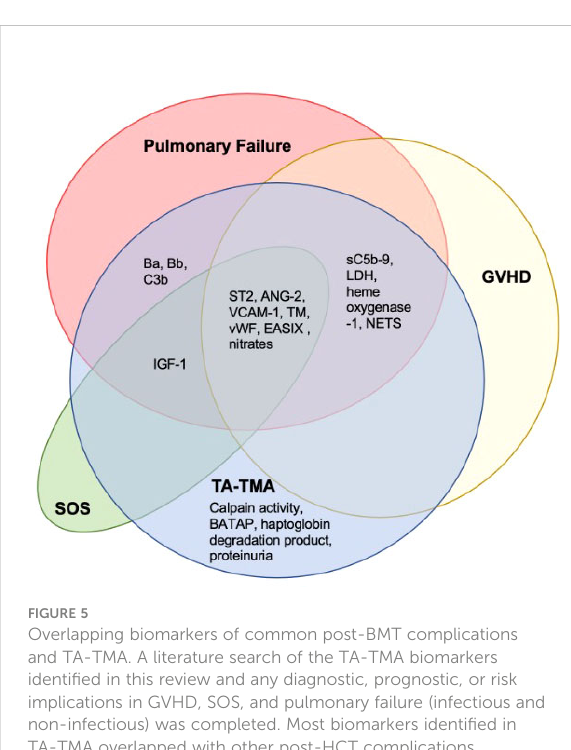
FIGURE 5 Overlapping biomarkers of common post-BMT complications and TA-TMA. A literature search of the TA-TMA biomarkers identi fi ed in this review and any diagnostic, prognostic, or risk implications in GVHD, SOS, and pulmonary failure (infectious and non-infectious) was completed. Most biomarkers identi fi ed in TA-TMA overlapped with other post-HCT complications. Citations provided in Supplementary Table 2. Abbreviations: lactate dehydrogenase (LDH), neutrophil extracellular traps (NETS), thrombomodulin